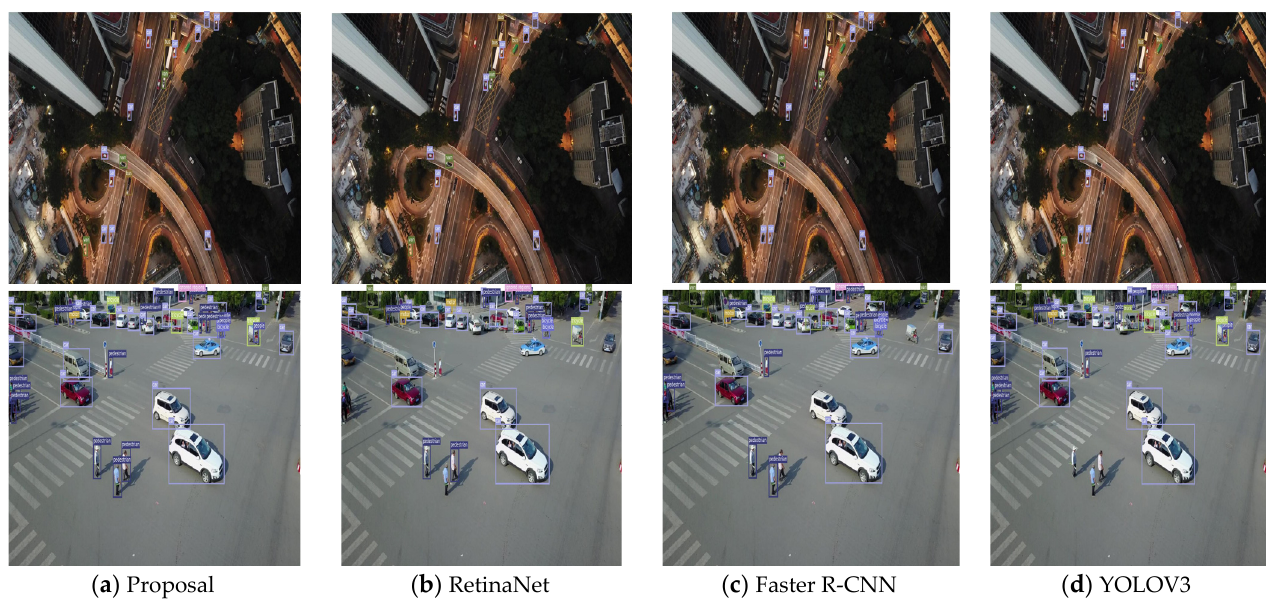
Figure 7. Comparison chart of the detection effect between the algorithm in this paper and some classic algorithms. ( a ) Proposal; ( b ) RetinaNet; ( c ) Faster R-CNN; ( d ) YOLOV3.